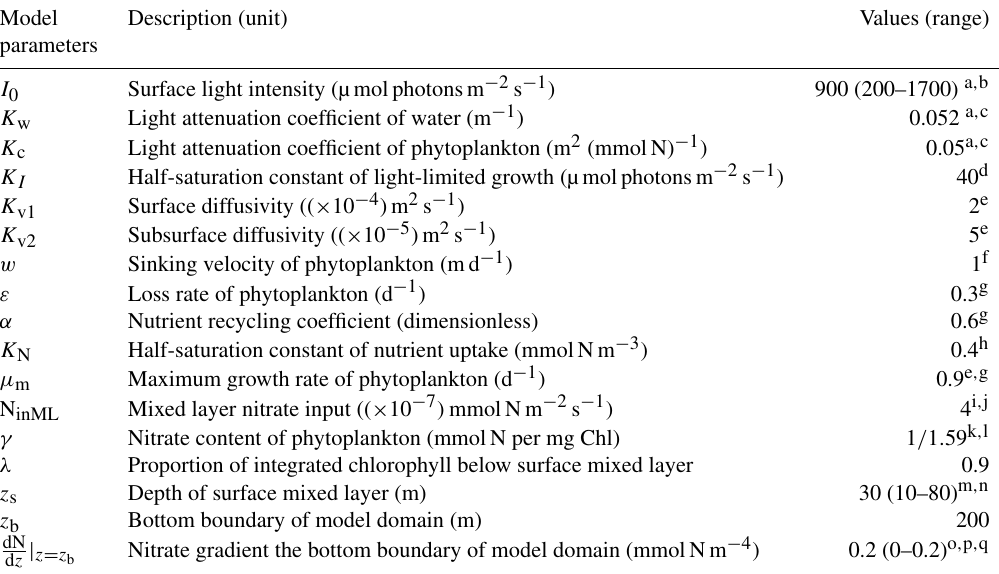
Table 1. List of symbols and their values used in models at SEATS station in northern SCS. Model Description (unit)